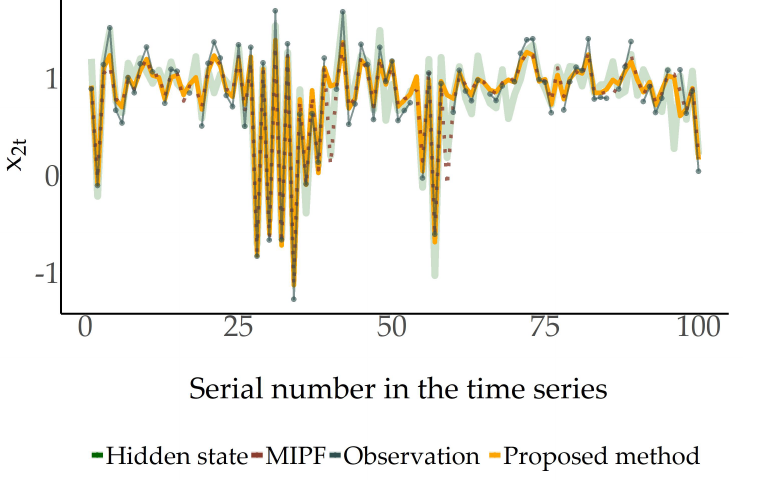
Figure 2. Time-series of the hidden values, the observations, and the corresponding point estimations of the proposed method and MIPF imputations for the second component x 2, t of the state